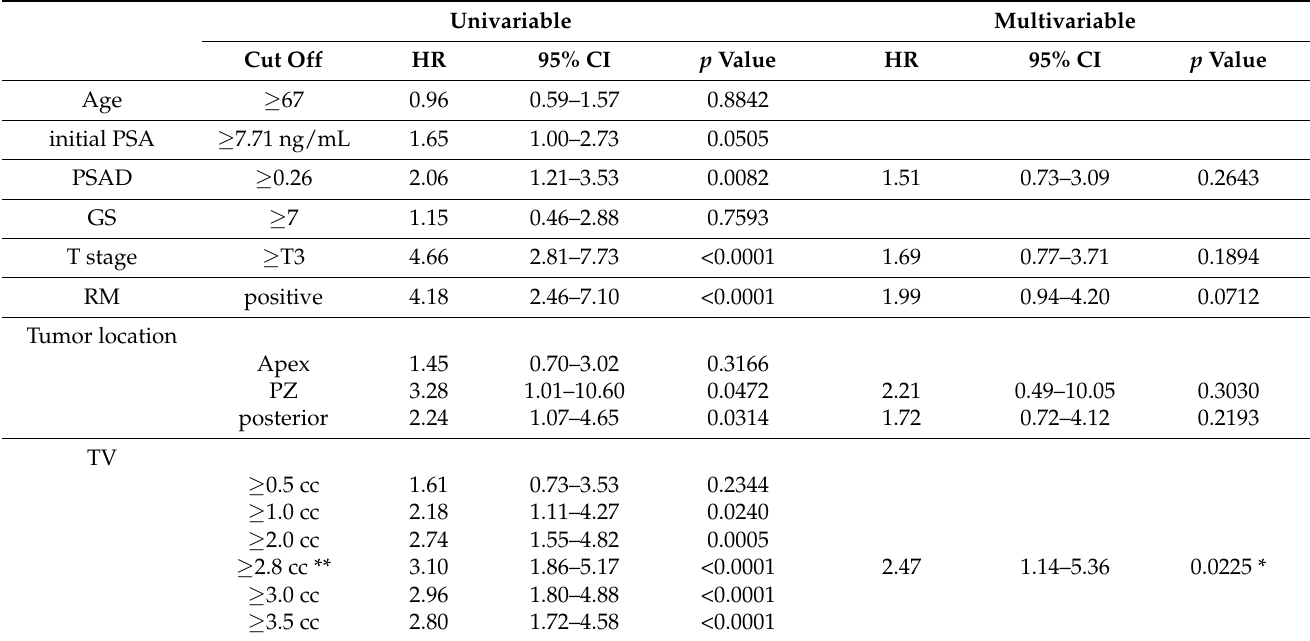
Table 2. Univariable and multivariable cox proportional hazard regression models in predictive factors for PFS in localized Pca (overall risk). Univariable